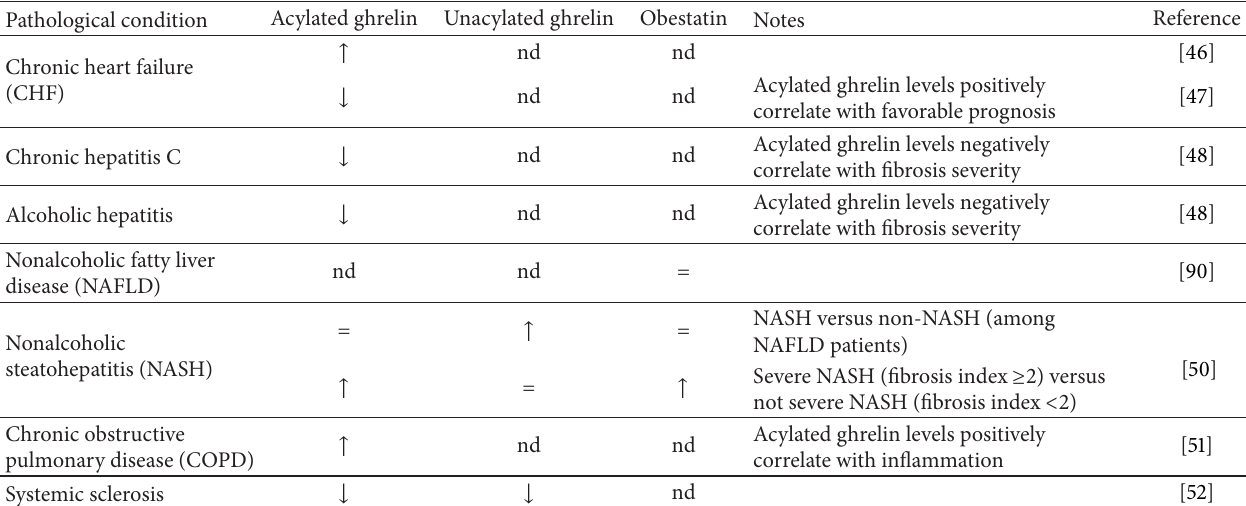
Table 1: Changes of acylated ghrelin, unacylated ghrelin, and obestatin blood concentrations in human pathological conditions leading to organ